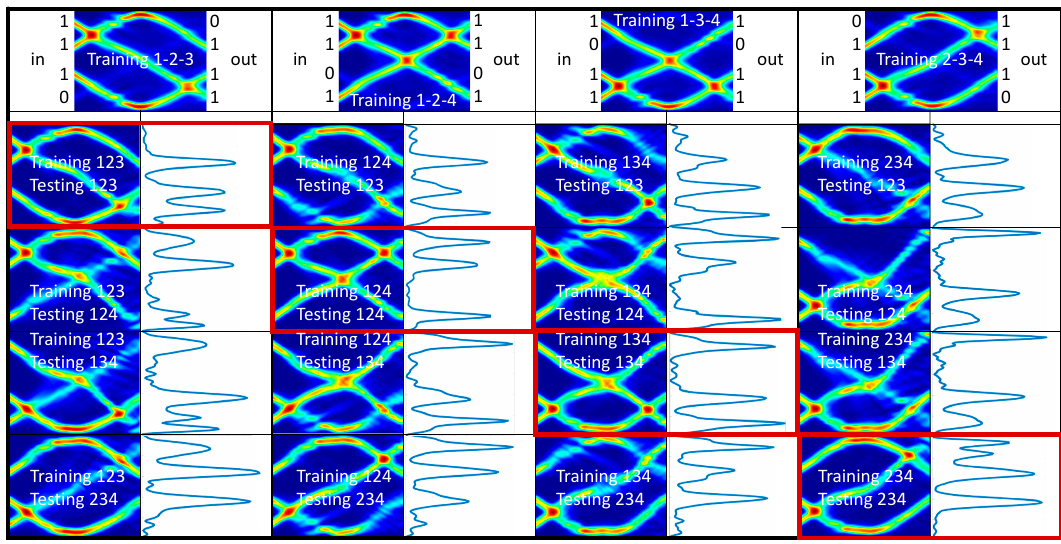
Figure 13. Training and testing phases are reported for 3-digit, 4-bit numbers. In the first raw, the training phases are reported. In the following raws, the testing experiments are reported. Those for which training and testing numbers coincide are framed in red.